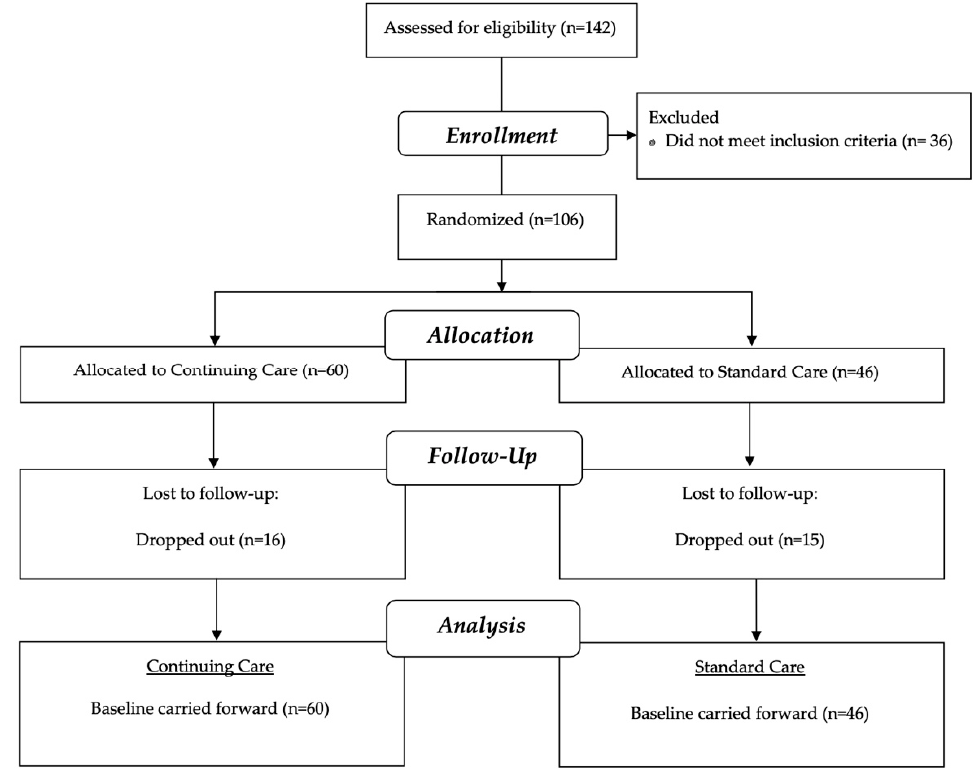
Figure 1. Participant flow through this